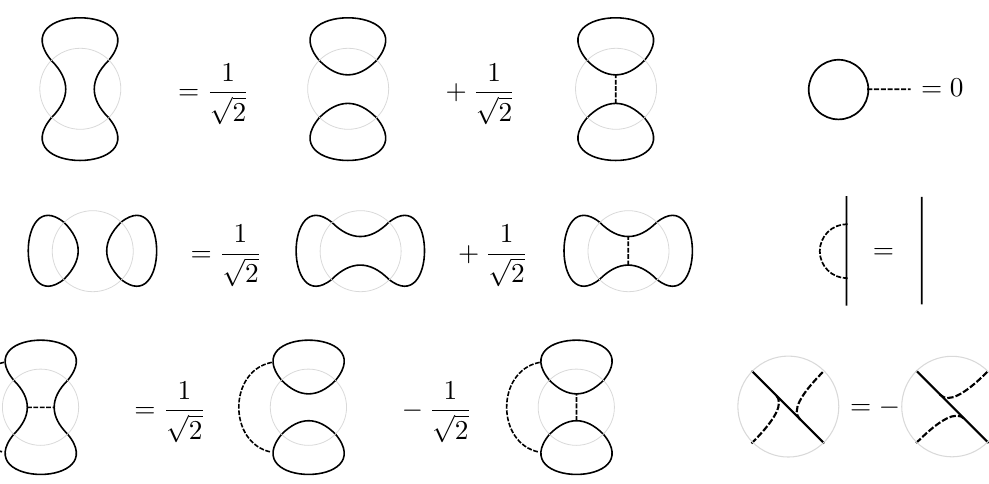
Figure 31 . Some consequences of the H-junction crossing relations and constraints thereof.